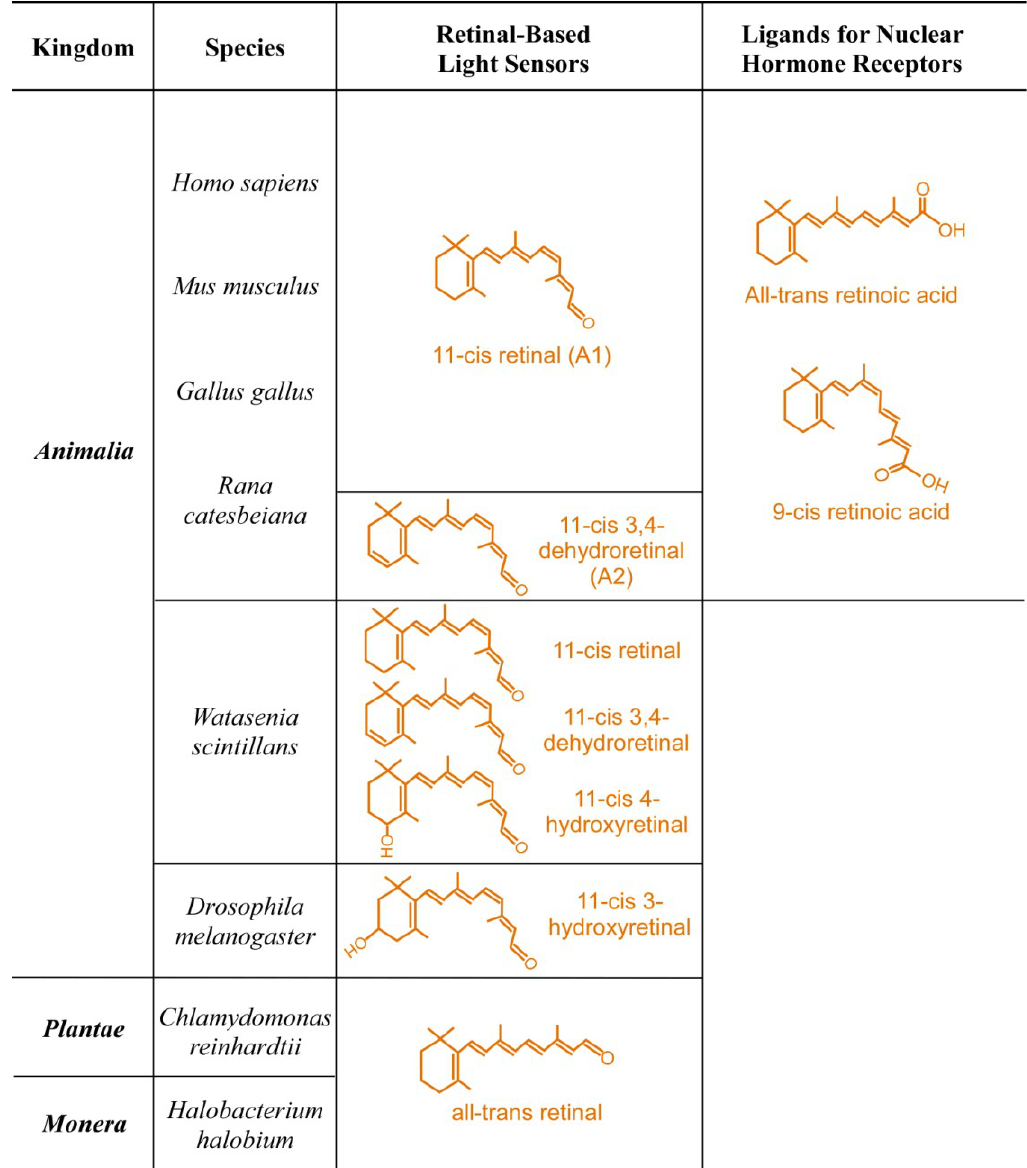
Figure 1. Examples of structural divergence of biologically active retinoids. For simplicity, only representative biologically active endogenous retinoids are